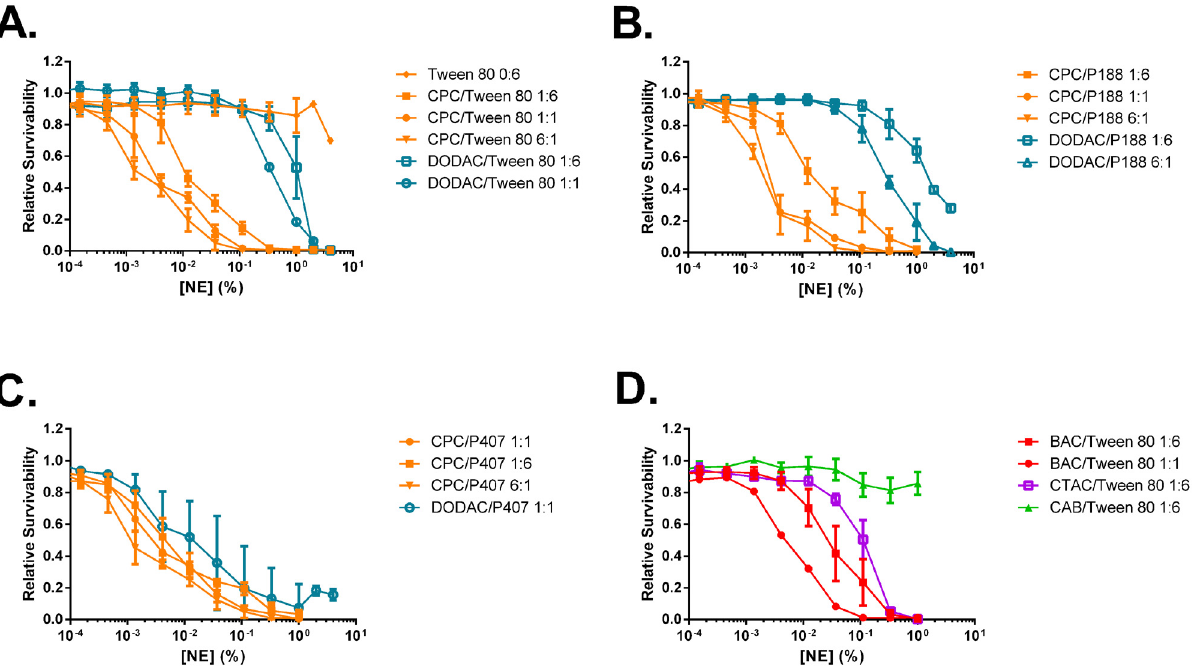
Fig 4. NE induced cytotoxicity for TC-1 cells. Cells were treated for 24 h with increasing concentrations of NE at 37°C. Cytotoxicity was measured with a CellTiter-Glo luminescent cell viability assay. Data for representative NEs grouped by nonionic surfactant are shown. Viability curves for NEs containing (A) Tween80, (B) P188, and (C) P407 with CPC or DODAC cationic surfactants, and for NEs containing (D) Tween80 with BAC, CTAC, and CAB. Curves shown are the average of two independent experiments ± SD.